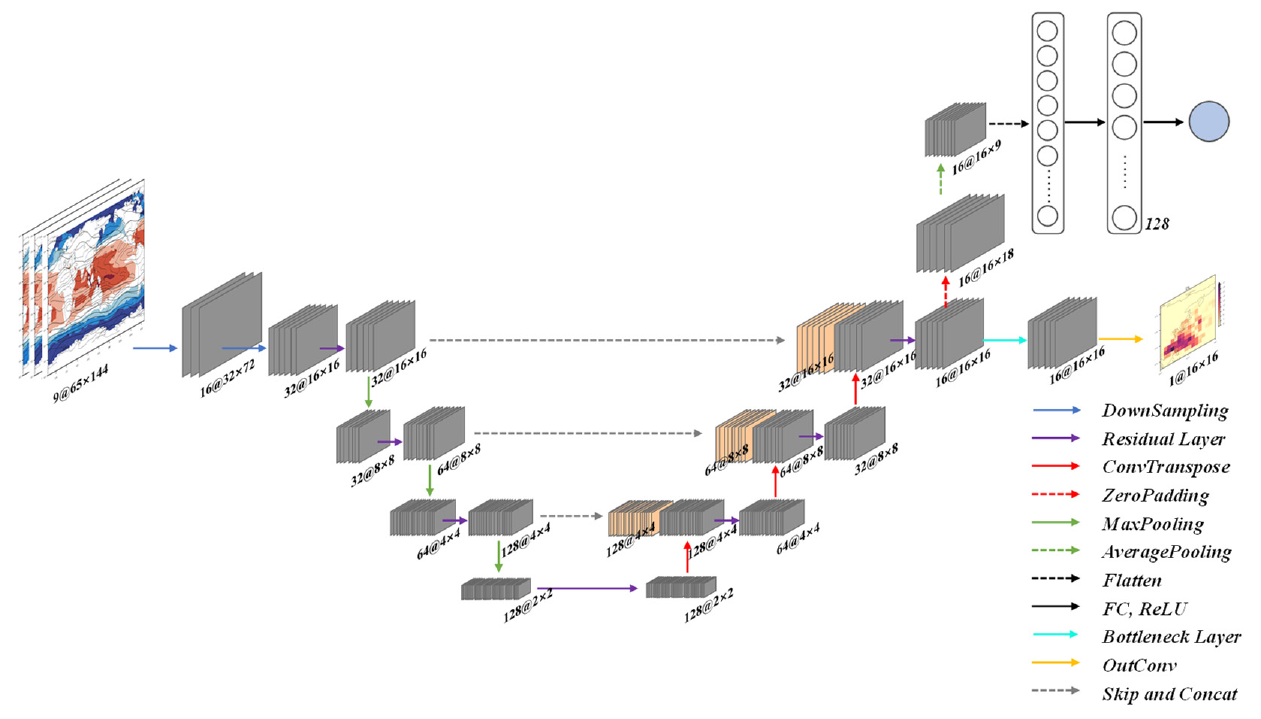
Figure 1. Schematic diagram of the SeaUnet network structure.